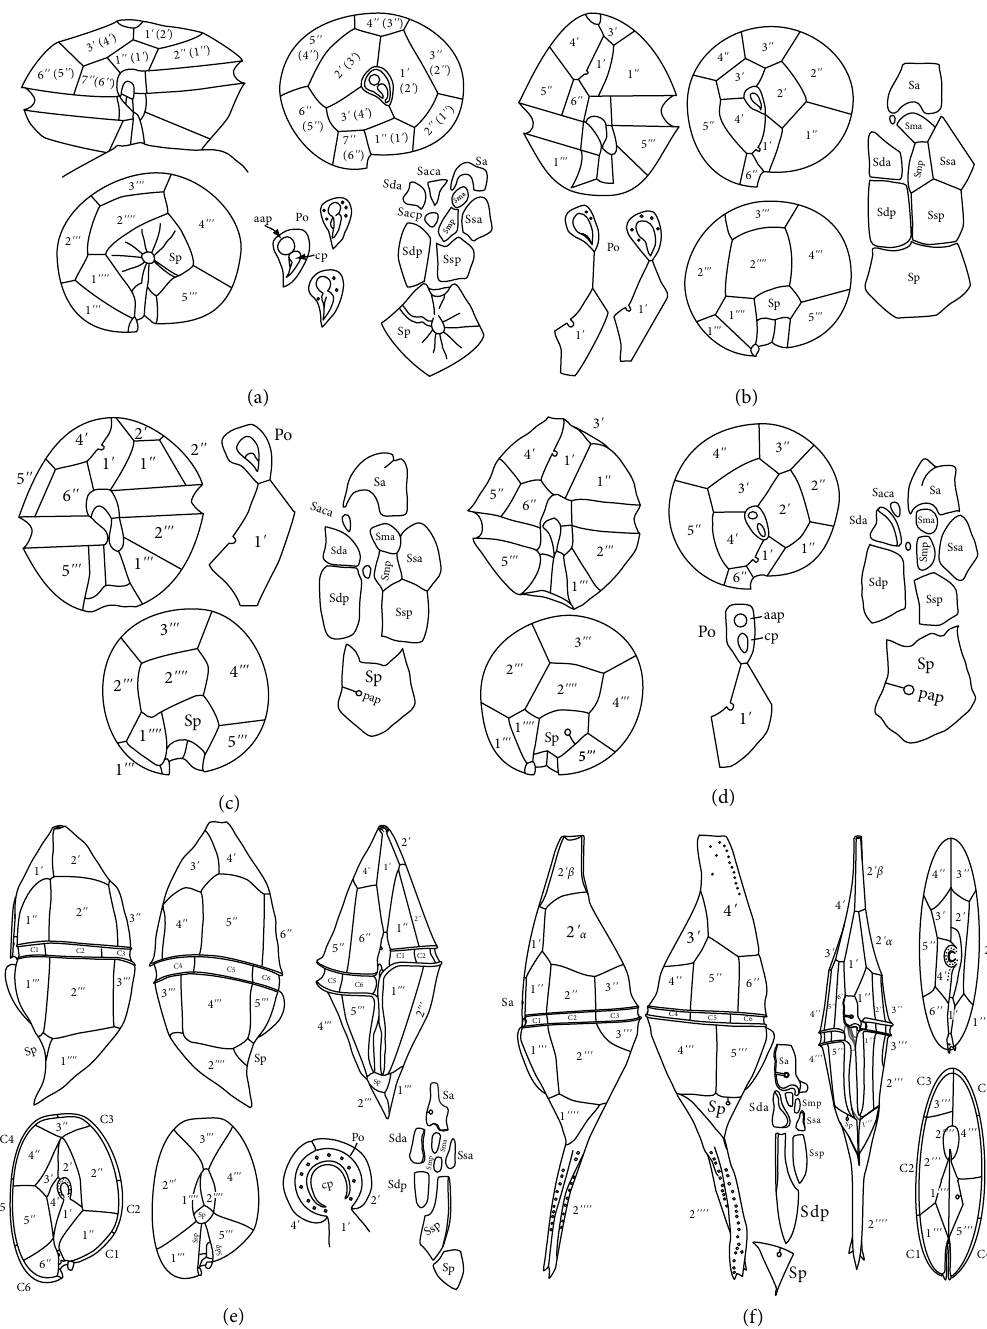
Figure 6: Line drawings of the ventral, apical and antapical views, apical pore plate and sulcal plates of Alexandrium sensu lato and Centrodinium . (a) Gessnerium monilatum redrawn and modified from Balech (1995). (b) Alexandrium minutum redrawn and modified from Balech (1989, 1995). (c) Protogonyaulax tamarensis redrawn and modified from Balech (1995). (d) Episemicolon affine gen. & comb. nov. (formerly A. affine ) redrawn and modified from Balech (1995). (e) Centrodinium punctatum . (f) Centrodinium eminens . = postcingular plates; 1 –2 = antapical plates; a.a.p. = anterior attachment pore; C1–C6 = cingular plates; c.p. = closing, cover plate or canopy; p.a.p. = posterior attachment pore; Po = apical pore plate; S.a. = anterior sulcal plate; S.a.c.a. = anterior accessory sulcal; S.a.c.p. = posterior accessory sulcal; S.d.a. = right (dexter) anterior lateral sulcal; S.d.p. = right ′′′ ′′′′ ′′′′ posterior lateral sulcal; S.m.a. = anterior median sulcal; S.m.p = posterior median sulcal; S.p. = posterior sulcal; S.s.a. = left (sinister) anterior lateral sulcal; S.s.p. = left posterior lateral